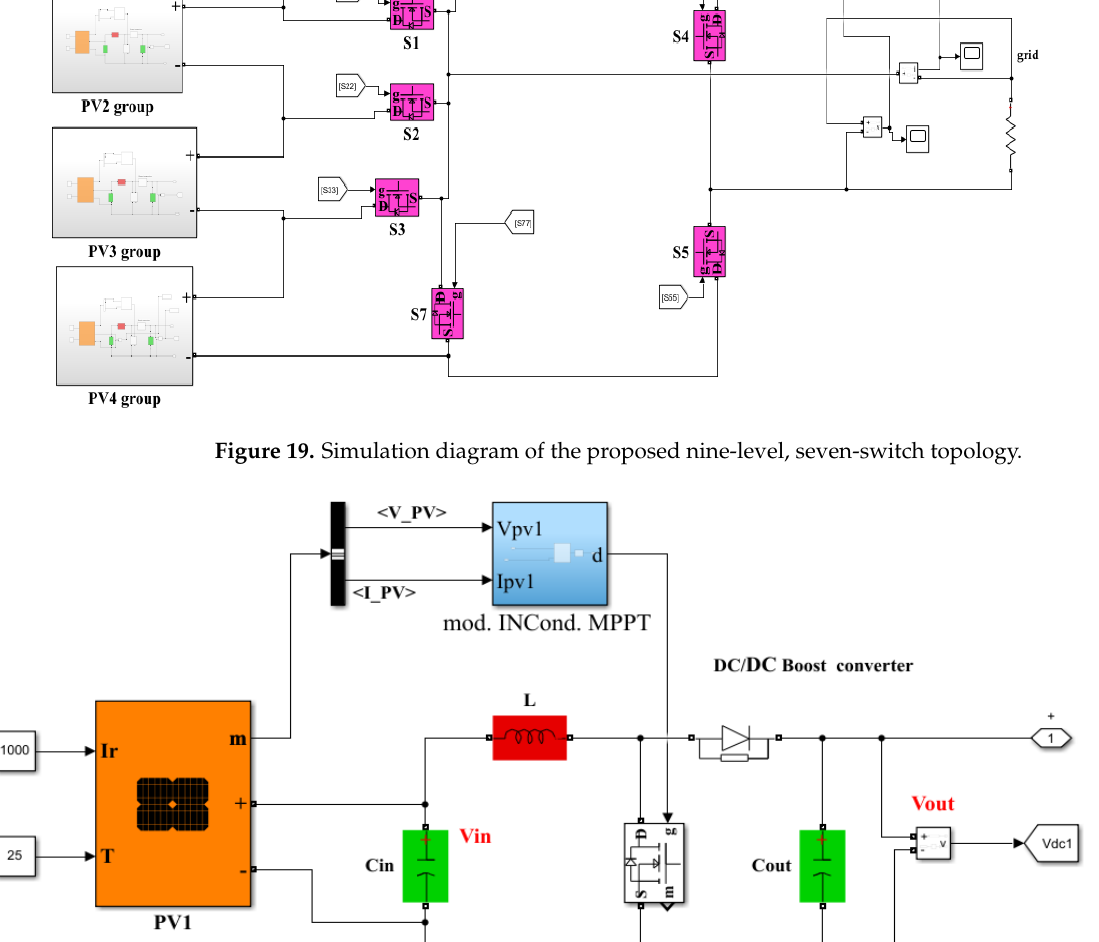
100 V Figure 21. V-I and P-V characteristics of the PV system under PSC.